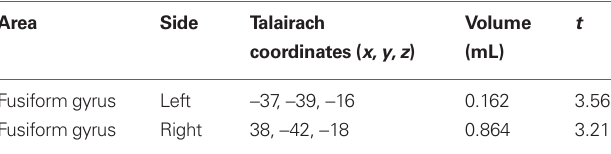
Table 2 | Regions of cortex identified as being more active for